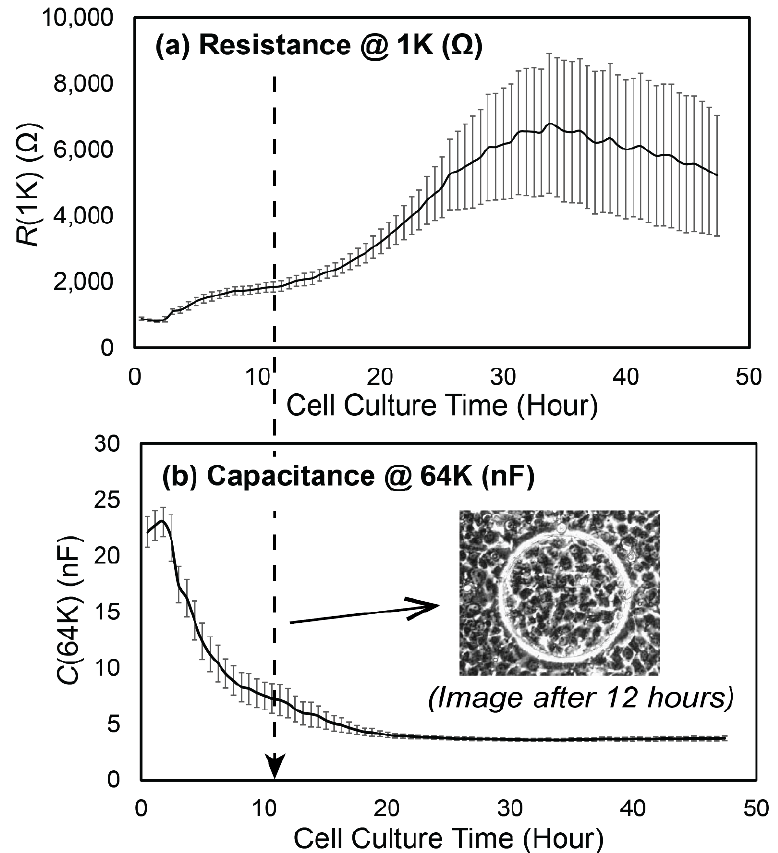
Figure 6. Time evolution of ( a ) R (1K) and ( b ) C (64K) as the cell layer was cultured. We use R (1K) to monitor the integrity of cell–cell tight junction, and C (64K) to monitor the cell layer confluence. The microscopic image in ( b ) is a representative image of the layer confluency at t = 12 h. Error bars are standard deviations of the n = 8 nodes in the flow chamber.